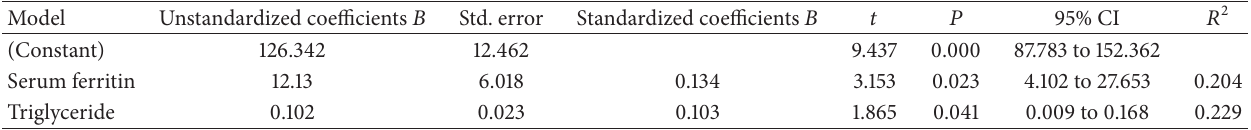
Table 3: Multiple linear regression analyses for HOMA-IR (stepwise method).